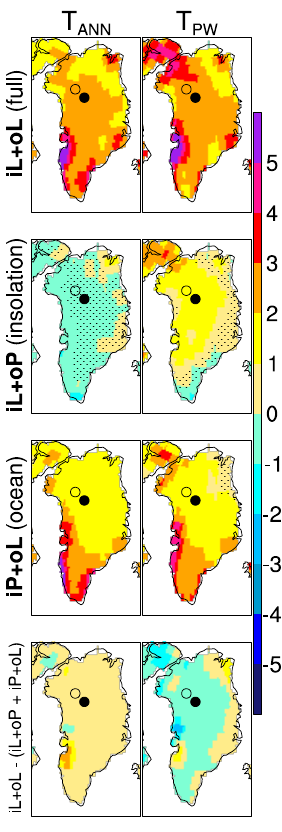
Figure 5. Near-surface air temperature anomalies (K) relative to iP+oP in iL+oL (top row), iL+oP (second row), iP+oL (third row), and the difference iL+oL − (iL+oP + iP+oL) (bottom row): an- nual mean (left column) and precipitation-weighted mean (right column). Black dotted shading marks anomalies that are not sta- tistically significant at the 95% level. dNEEM (NEEM) location is marked with the filled (hollow) black circle. Note the changed color bar compared to the seasonal means.